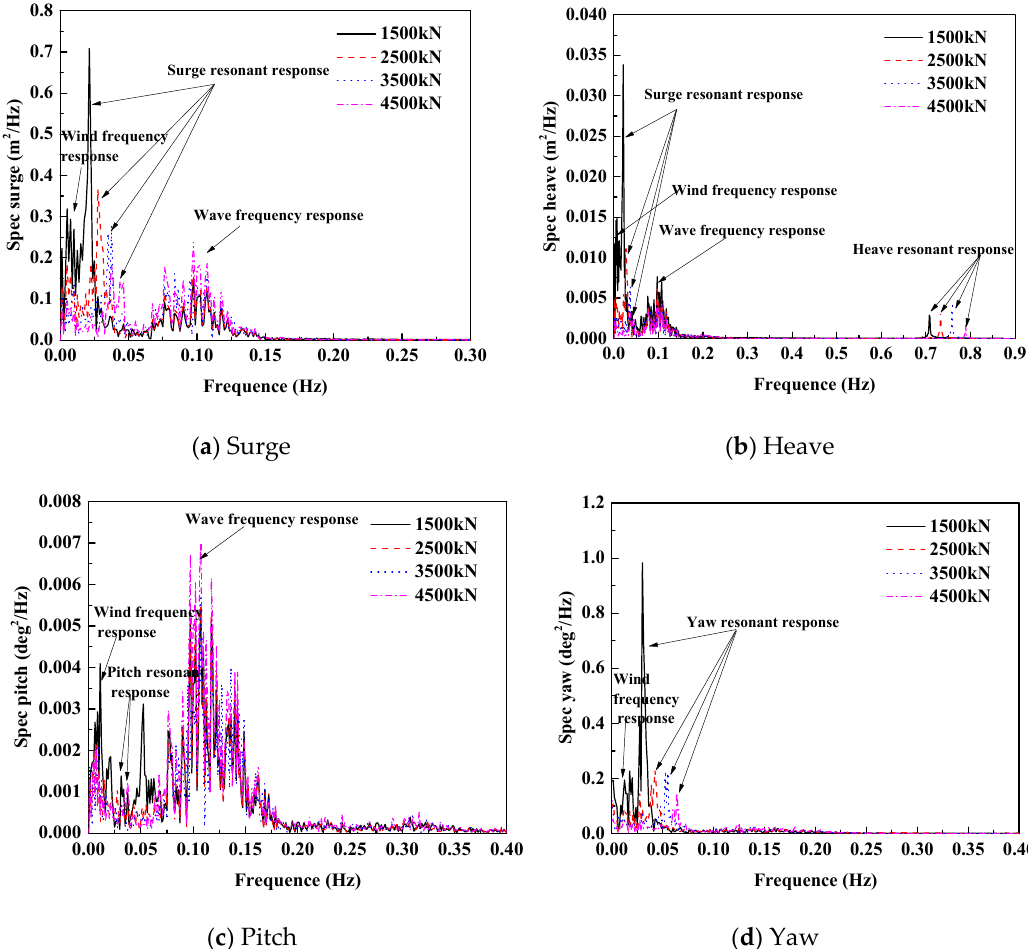
Figure 13. Power spectra of motions in surge, heave, pitch and yaw in different pretension conditions.